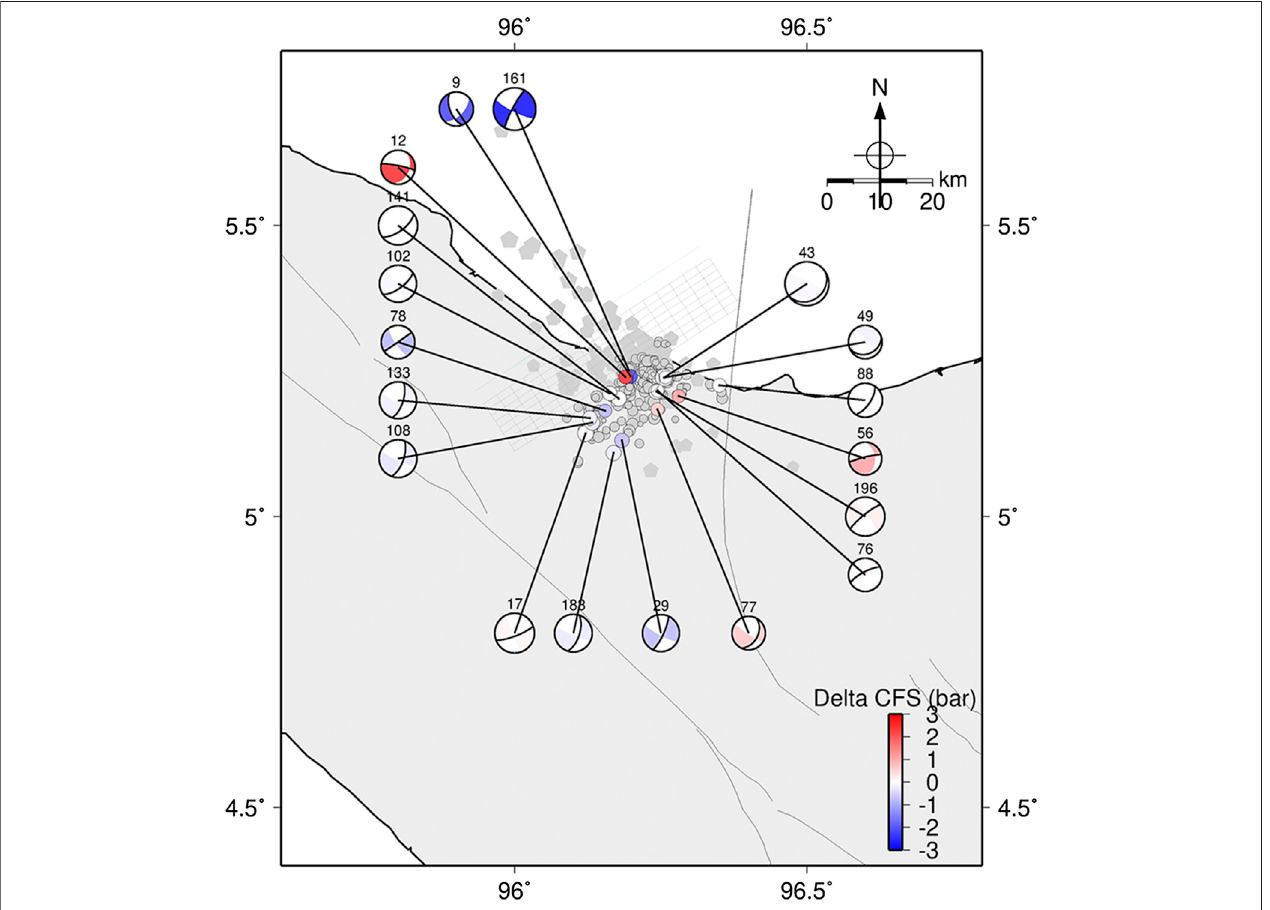
FIGURE 10 | Map view of the Δ CFS of 2016 Pidie Jaya main shock resolved in the NE-SW aftershock focal mechanism nodal planes; except for events 9 and 12. The focal mechanisms are colored, based on the Δ CFS value. Bold nodal lines are the chosen nodal planes. Numbers above the focal mechanisms show the event number.